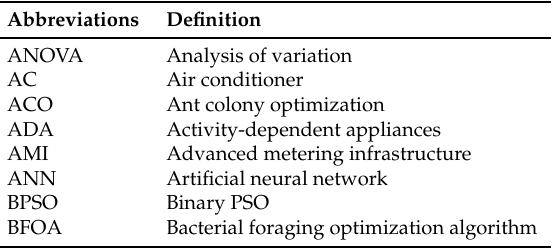
Table 2. List of